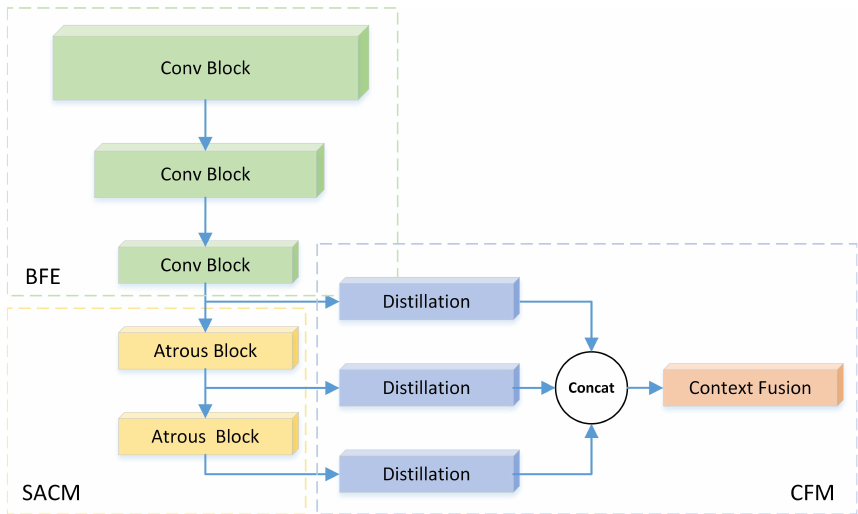
Figure 2. Overview of the proposed network for density estimation. The network extracts common feature maps with reduced spatial resolution using basic feature extractor (BFE). To ensure a diversity of contextual features, the stacked à trous convolution module (SACM) enlarges the gap between the receptive sizes of the feature maps. The context fusion module (CFM) distills different contextual information and fuses it to estimate the density